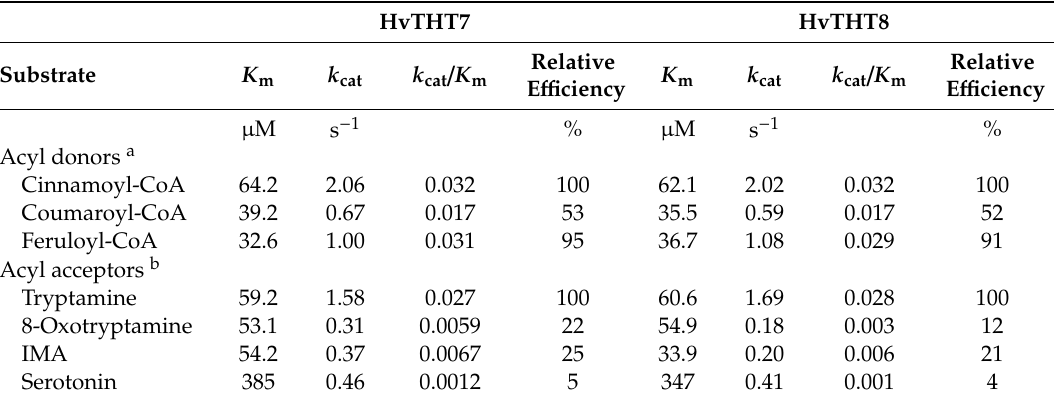
Table 2. Kinetic Parameters of HvTHT7 and HvTHT8.